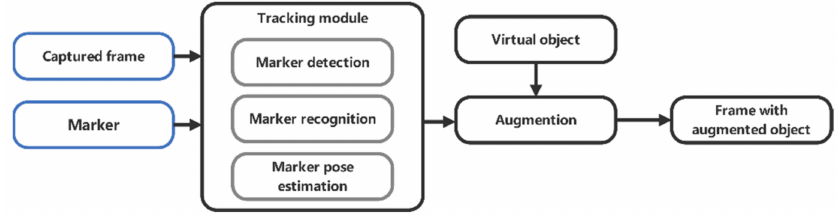
Figure 1. Marker-based AR system flow